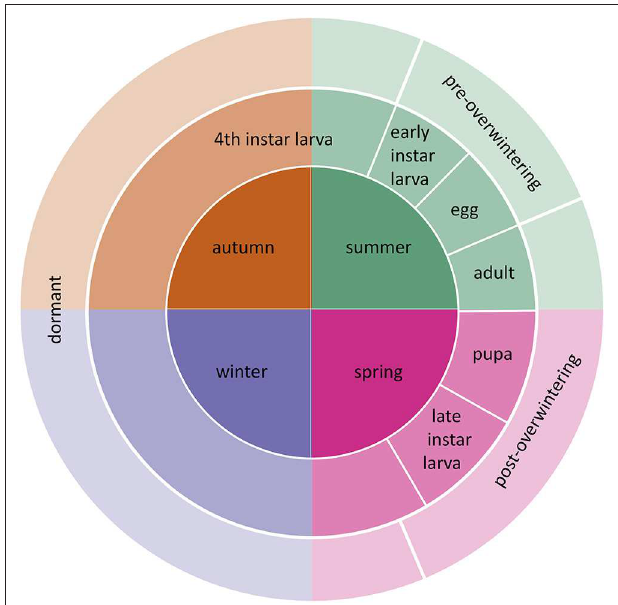
FIGURE 1 | Life cycle of E. p. phaeton and the corresponding season when each stage occurs. Counterclockwise, eggs are laid in summer, they hatch into pre-overwintering larvae, which turn into dormant larvae upon molting into 4th instar. Larvae remain dormant during part of the summer, autumn, and winter. Post-overwintering larvae resume feeding and pupate the following spring and adults start the next life cycle.